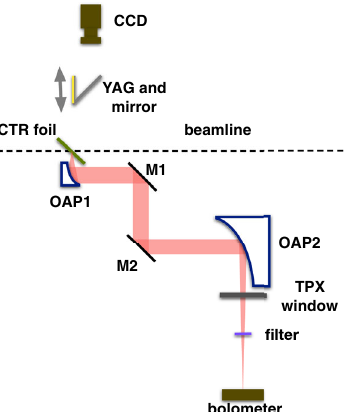
FIG. 8. The schematic of the CTR collection setup.